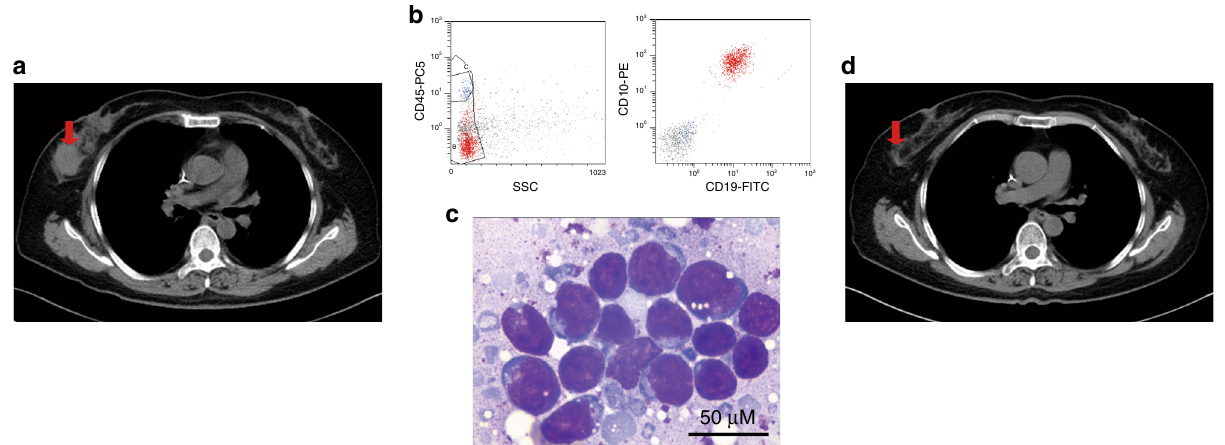
Fig. 6 Diagnosis and therapeutic evaluation of EMDs before and after Sino 19 cell infusion. B-ALL presented as a large breast mass in a patient with EMDs. a Computed tomography shows a large mass in the right breast (red arrow). b Flow cytometry on a breast mass sample acquired by puncture biopsy: shows CD19 and CD10 positive B lymphoblasts. c Cell morphology (Wright – Giemsa staining) shows lymphoblasts. At least three smears from this aspirated mass tissue were produced and stained, then three pathologists independently performed morphological view and evaluation, the fi nal diagnosis was established when they had the consistent fi ndings. Scale bar: 50 μ M. d Computed tomography shows disappeared large mass at Day 50 following Sino 19 cell infusion (red